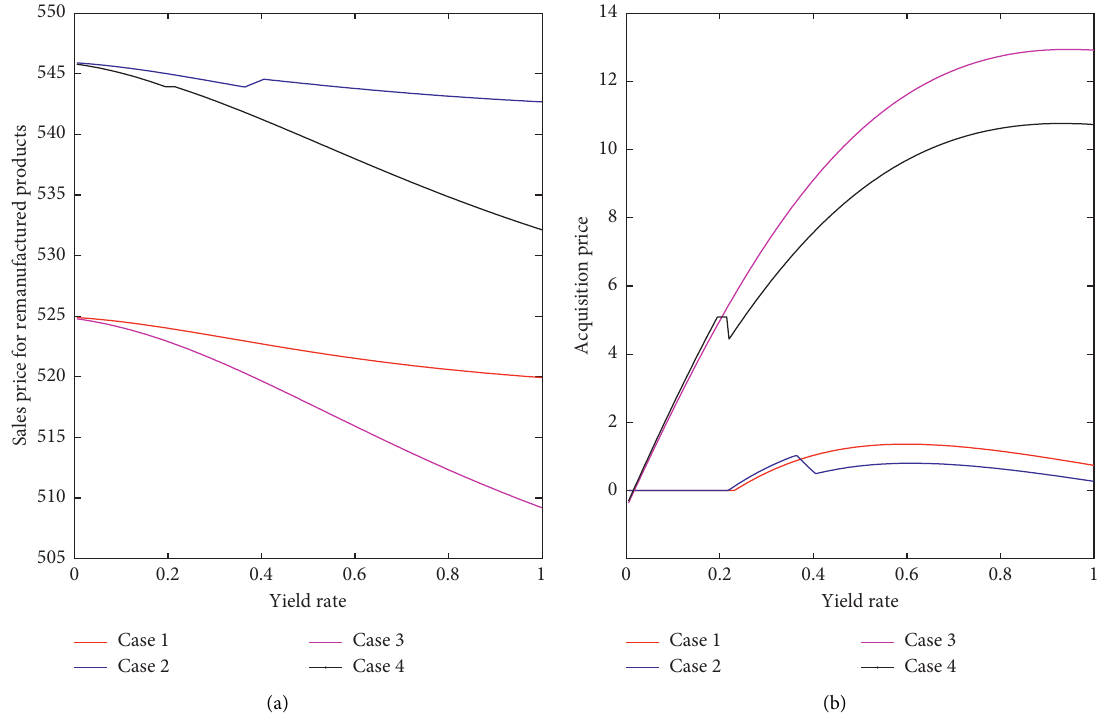
Figure 3: (a) Sales price for remanufactured products and (b) acquisition price for used products vs. yield